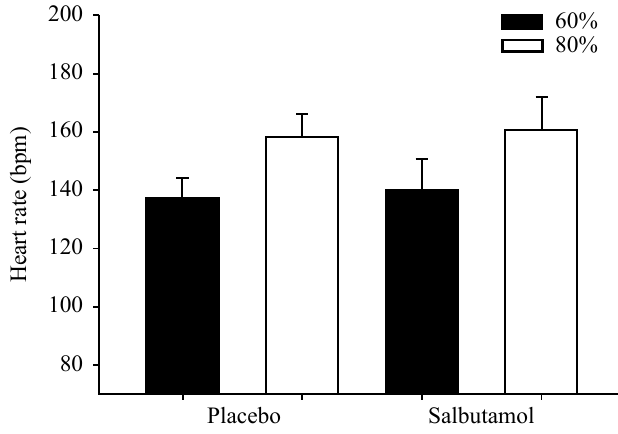
Figure 3. Mean and SD of HR vonen formula.